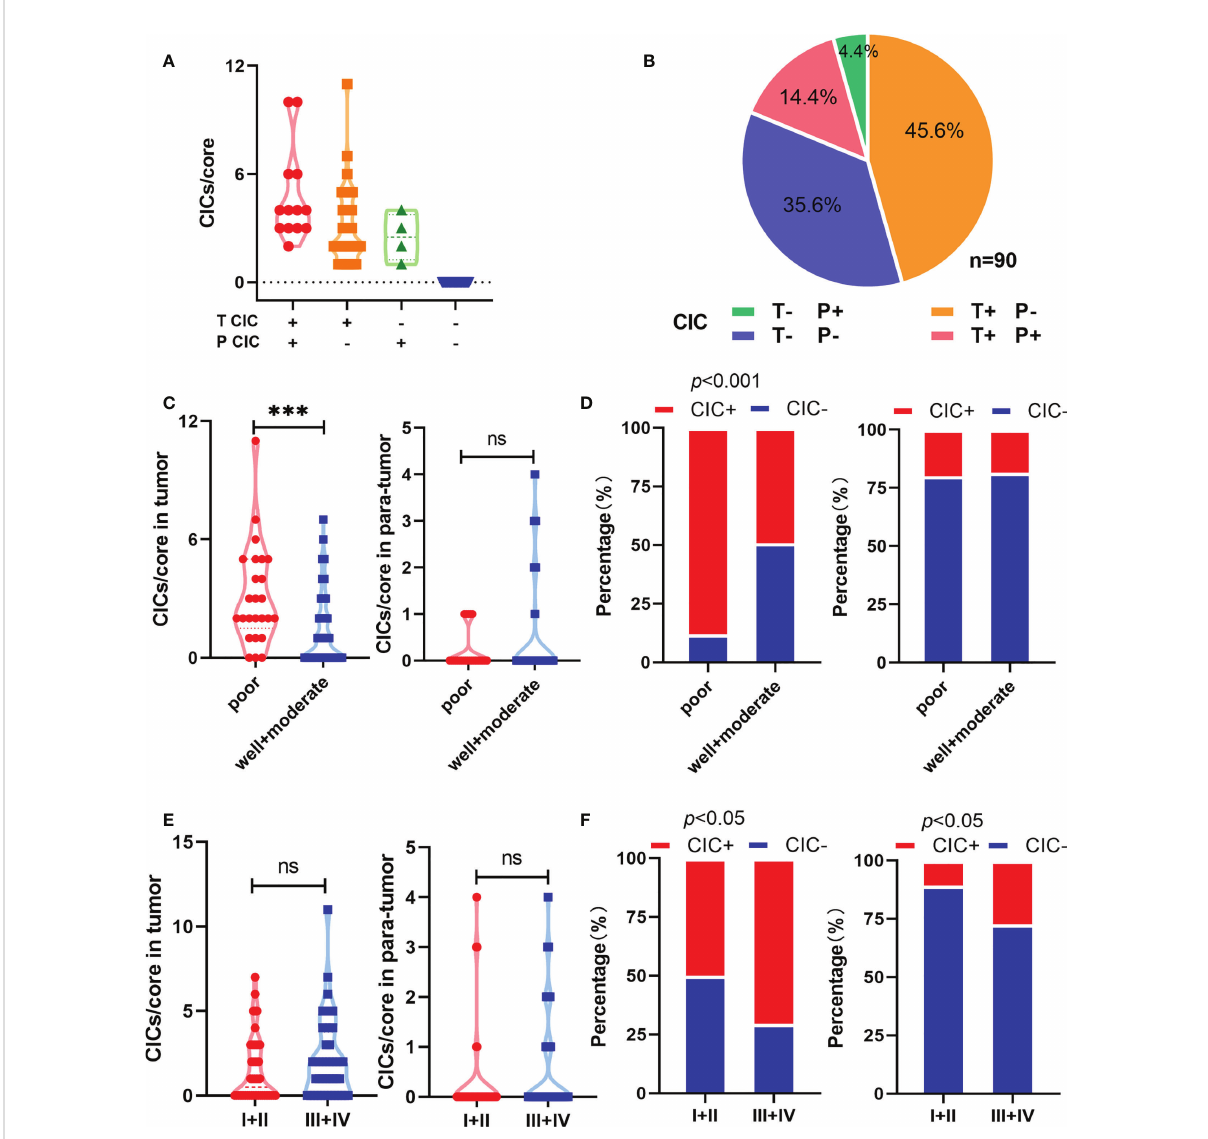
FIGURE 2 Homotypic CICs are associated with clinicopathological characteristics in HCC tissues. (A) CIC counts normalized by core area in CIC positive tumor and para-tumor tissues. (B) Quanti fi cation of CICs in tumor and para-tumor tissues. (C) Quanti fi cation of CICs strati fi ed by histological grade in tumor (left) and para-tumor tissues (right). (D) CIC compositions by histological grade in tumor (left) and para-tumor tissues (right). (E) Quanti fi cation of CICs strati fi ed by TNM in tumor (left) and para-tumor tissues (right). (F) CIC compositions by TNM in tumor (left) and para- tumor tissues (right). *P < 0.05; **P < 0.01; ***P < 0.001; ns, not signi fi